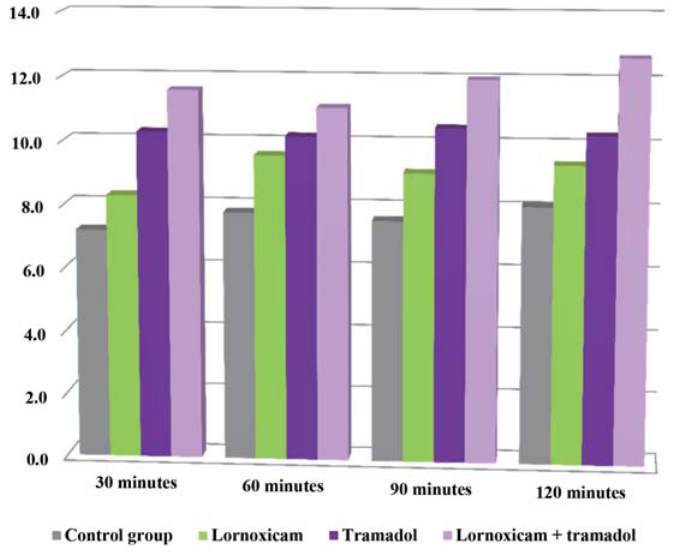
FIGURE 1. Comparation of analgesic effect of tested substances, after intraperito- neal